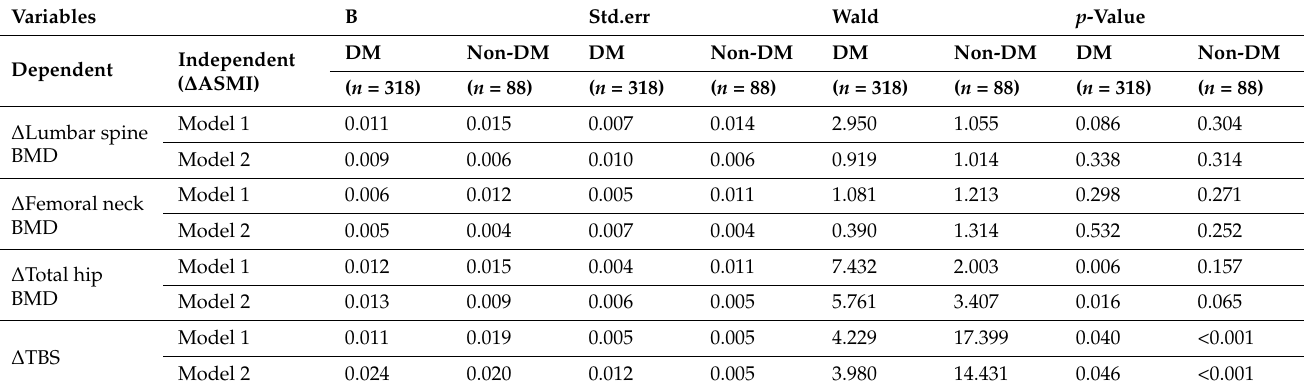
Table 4. GEE model of the association between the change in bone-related parameters and